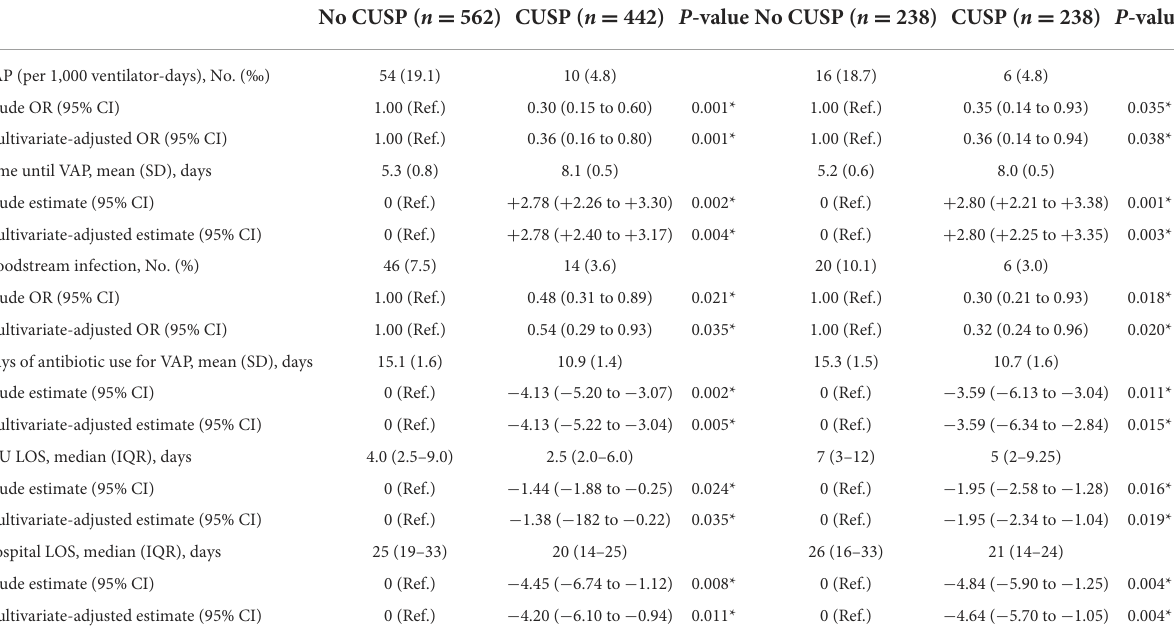
TABLE 6 Logistic regression or linear regression analysis for outcomes based on the initiation of CUSP in the SICU setting. Variables Before propensity matching After propensity